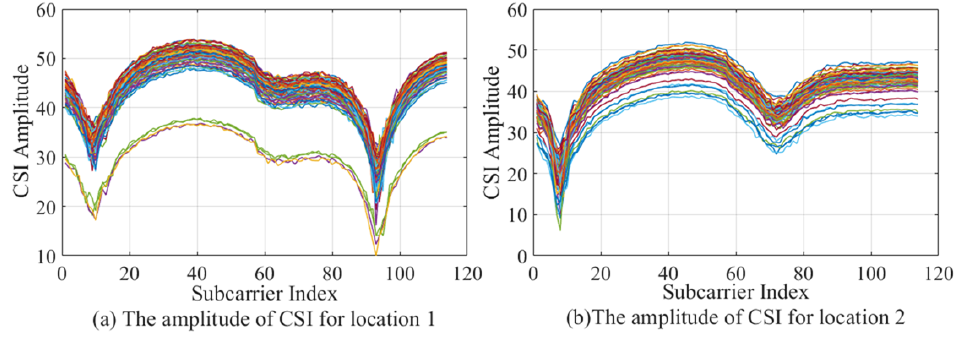
Figure 1. Channel State Information (CSI) amplitude at different